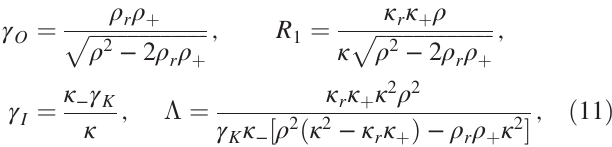
¯ P and the over which the active kinase K , ρ , κ , ρ , κ , ρ b b u u r r ¯ P ¯ S at WK